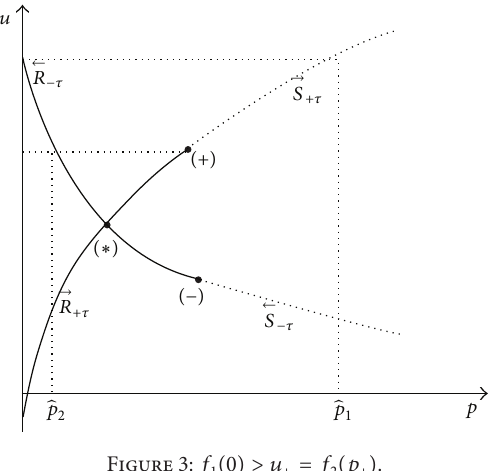
Figure 1: Elementary waves in the (𝑢, 𝑝) plane.